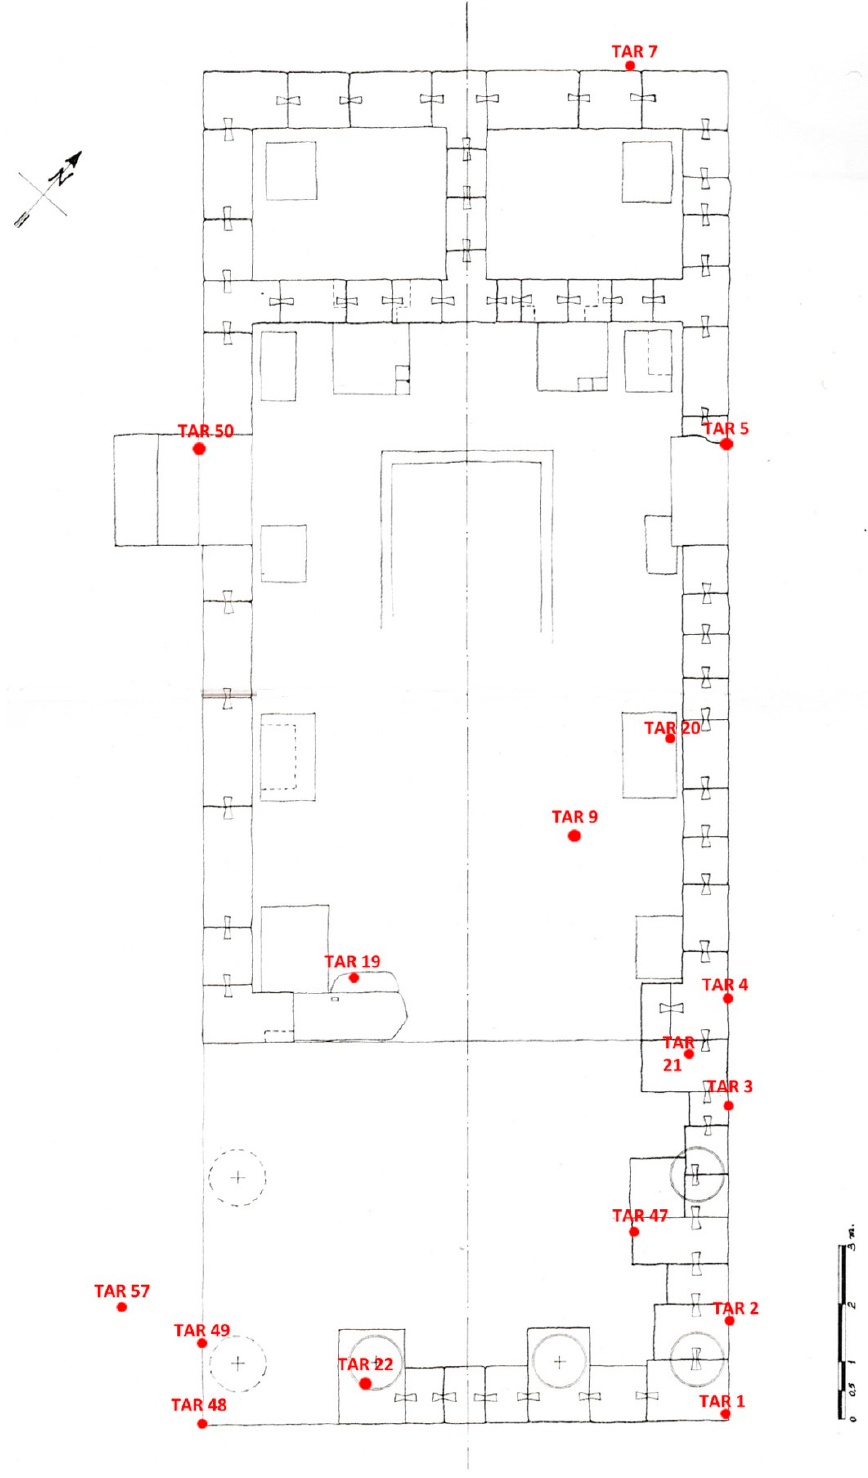
Figure 7. Sampling position on the map from the Roman Temple (from Zucca [1], modified).